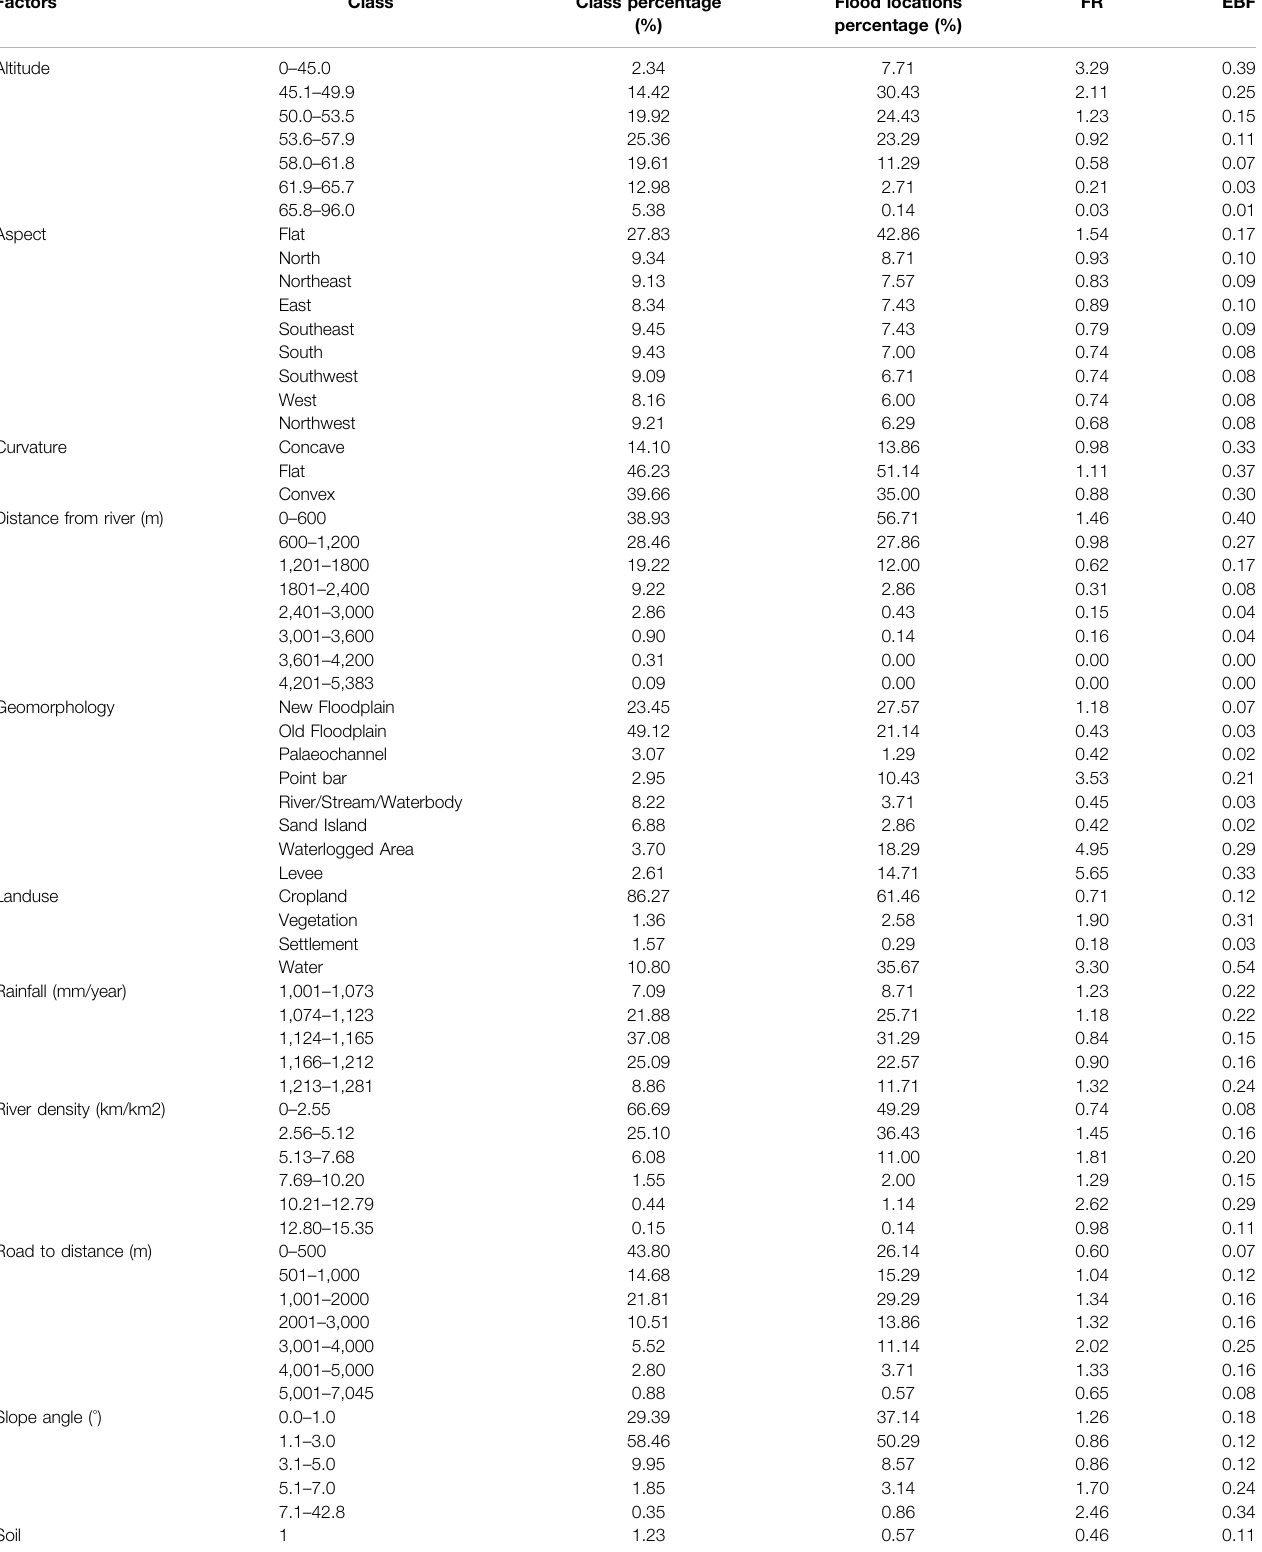
Flood locations FR EBF (%) percentage (%)